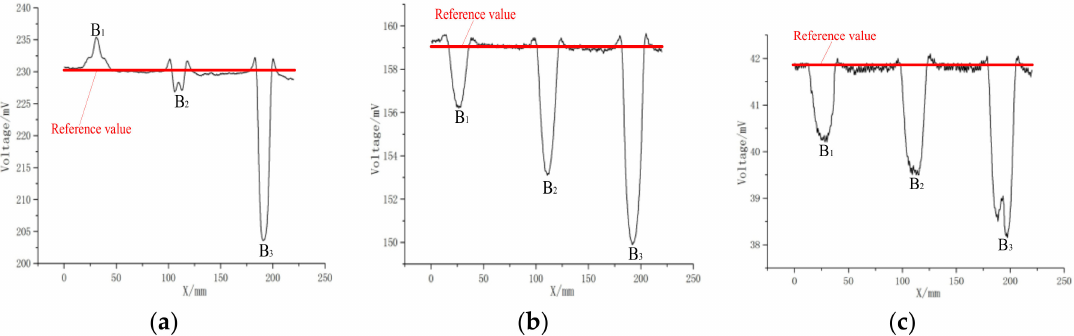
Figure 11. The signal strength diagrams with the multi-electrode sensor with 0.1 mm lift-off: ( a ) E21, ( b ) E31, ( c )